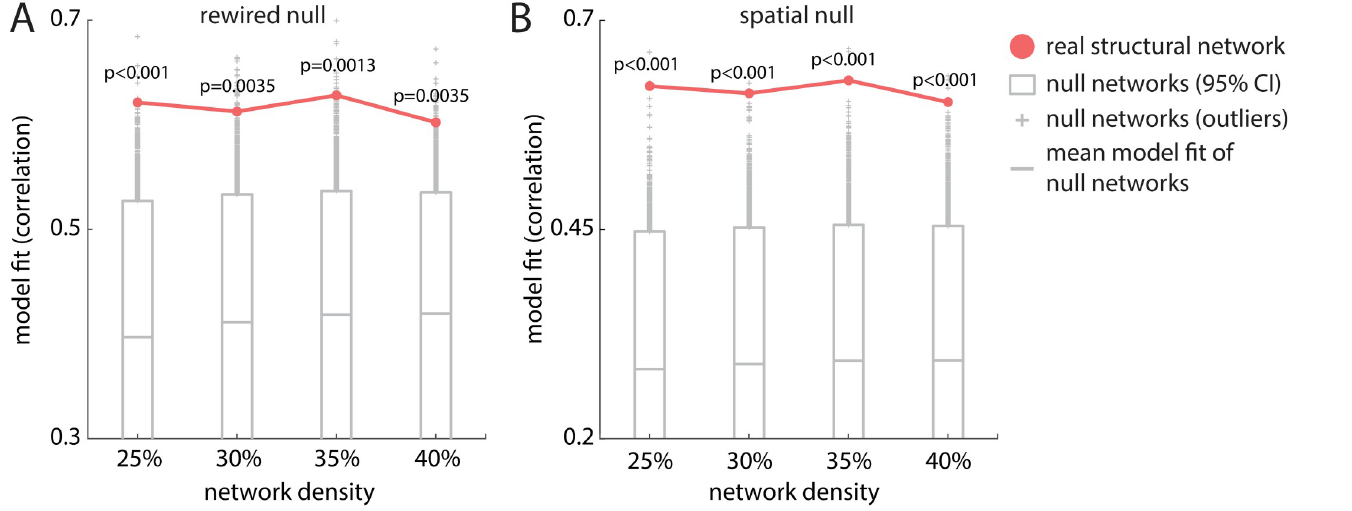
Fig 5. Effects of network topology and geometry. (A) Systematic disruption of connectome topology (rewired null). (B) Systematic disruption of spatial embedding (spatial null). Both procedures significantly degrade model fit as measured by Spearman’s correlation. Red = real structural network (empirical network); gray = null networks. Rewired null: p 25% < 0.001, p 30% = 0.0035, p 35% = 0.0013, p 40% = 0.0035; spatial null: p 25% < 0.001, p 30% < 0.001, p 35% < 0.001, p 40% < 0.0013). The underlying data can be found at https://github.com/yingqiuz/SIR_simulator/blob/master/results/Fig5.mat.